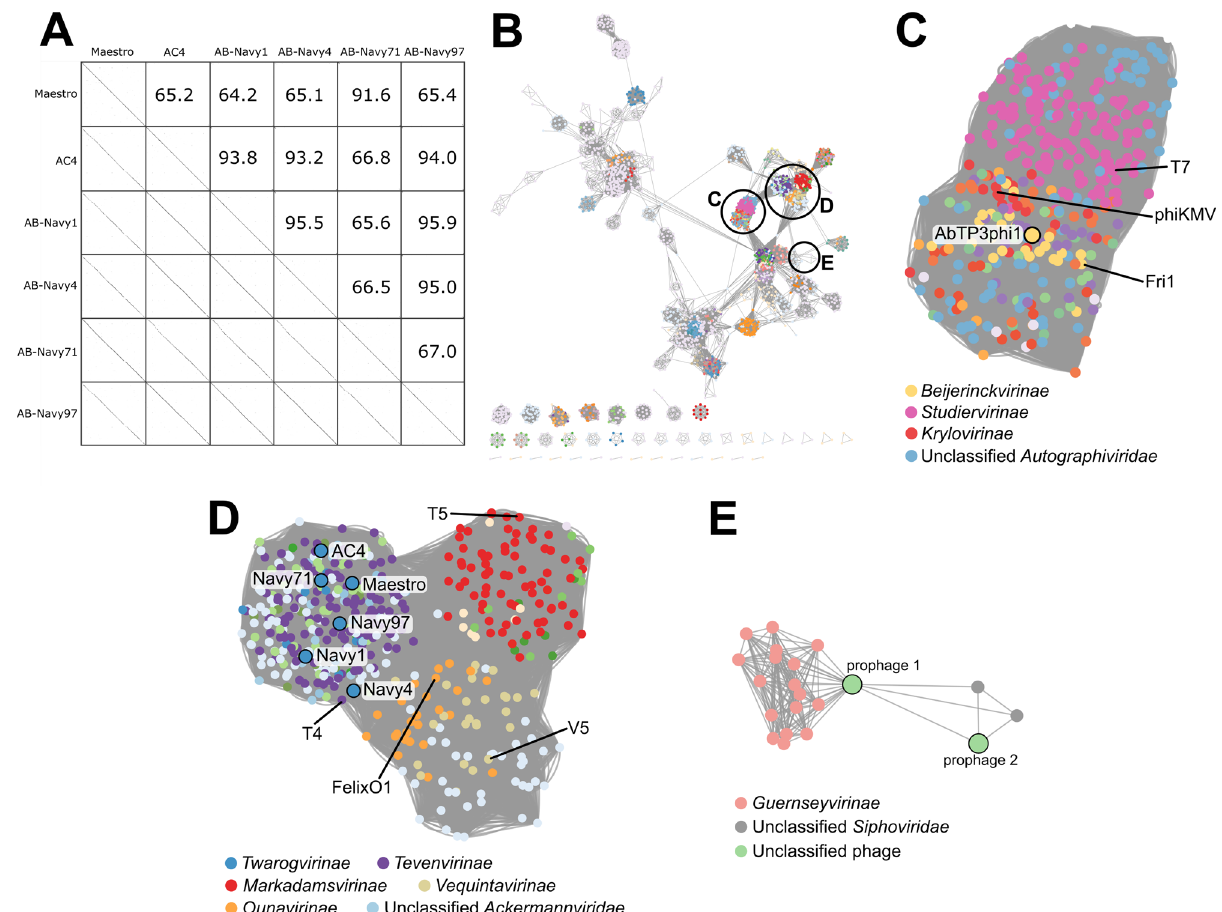
Fig. 1 DNA and protein-based relationships of the seven treatment phages. A DNA sequence relatedness of six T4-like myophages, showing pairwise percent DNA sequence identities as determined by ProgressiveMauve (upper section) and DNA dotplots visually representing DNA sequence alignments between phages (lower section). B Protein sequence-based relationships of 2834 Caudoviricetes phages representing all species in the ICTV taxonomy, plus the seven treatment phages and two prophages identi fi ed in strains TP1, TP2, and TP3. Unclustered singletons (17 in total) are removed from the visualization. Distinct colors are assigned at the Subfamily level; if no Subfamily was assigned, color is assigned at the Family level. Circled clusters are enlarged in C – E as labeled. C Enlarged cluster representing the Autographiviridae . Nodes are colored based on their Subfamily membership, with the legend identifying prominent clades; the node representing phage AbTP3phi1 is outlined in black, and nodes representing clade-founding phages T7, phiKMV and Fri1 are labeled. D Enlarged cluster containing the T4-like subfamilies, including the Twarogvirinae ; this large cluster is also linked to the T5-like Markadamsvirinae and clusters of diverse myophages including the V5-like Vequintaviridae and FelixO1-like Ounavirinae . Nodes are colored based on their Subfamily membership with the legend identifying prominent clades. Nodes representing the six treatment myophages are outlined in black, and nodes representing clade-founding phages T4, T5, FelixO1 and V5 are labeled. E Enlarged cluster containing the two prophage elements identi fi ed in strains TP1, TP2 and TP3. These prophages are not closely related to other classi fi ed phages, with the 52kb prophage 1 distantly linked to the Guernseyvirinae , and the 42kb prophage 2 related to two other unclassi fi ed